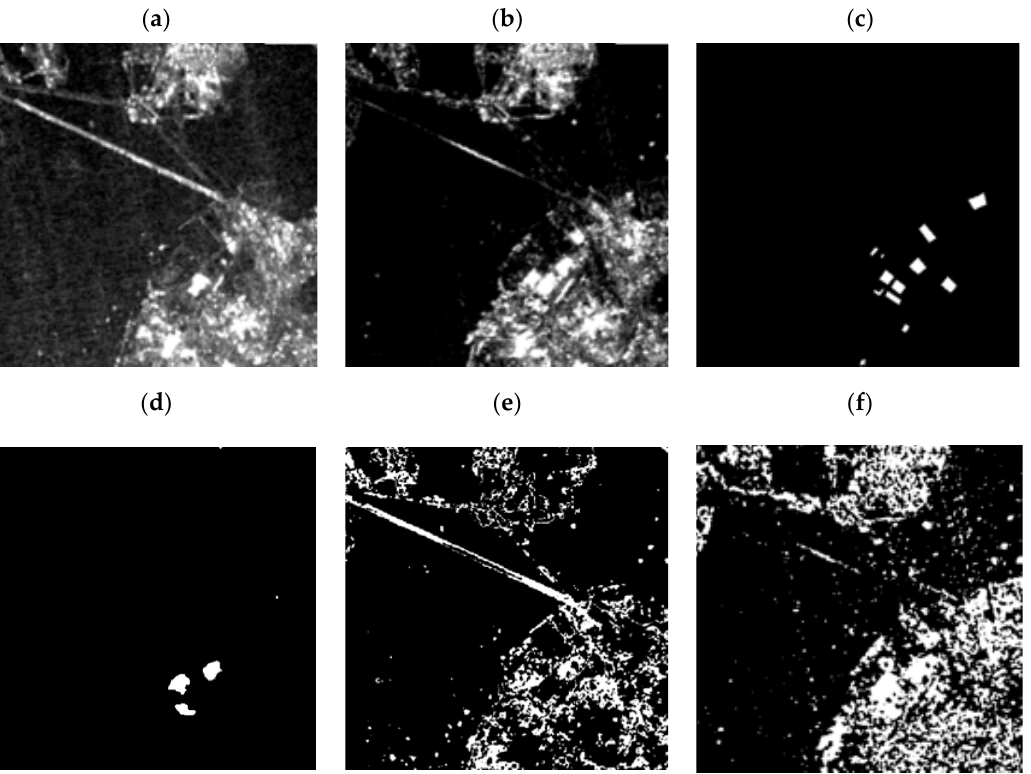
Figure 13. Result of the second Xiamen test site. The resolution of each image is 6 km × 6 km. ( a ) Time 1 SAR data, ( b ) Time 2 SAR data, ( c ) ground truth, ( d ) result of proposed model, ( e ) result of FCM, ( f ) result of Otsu thresholding.